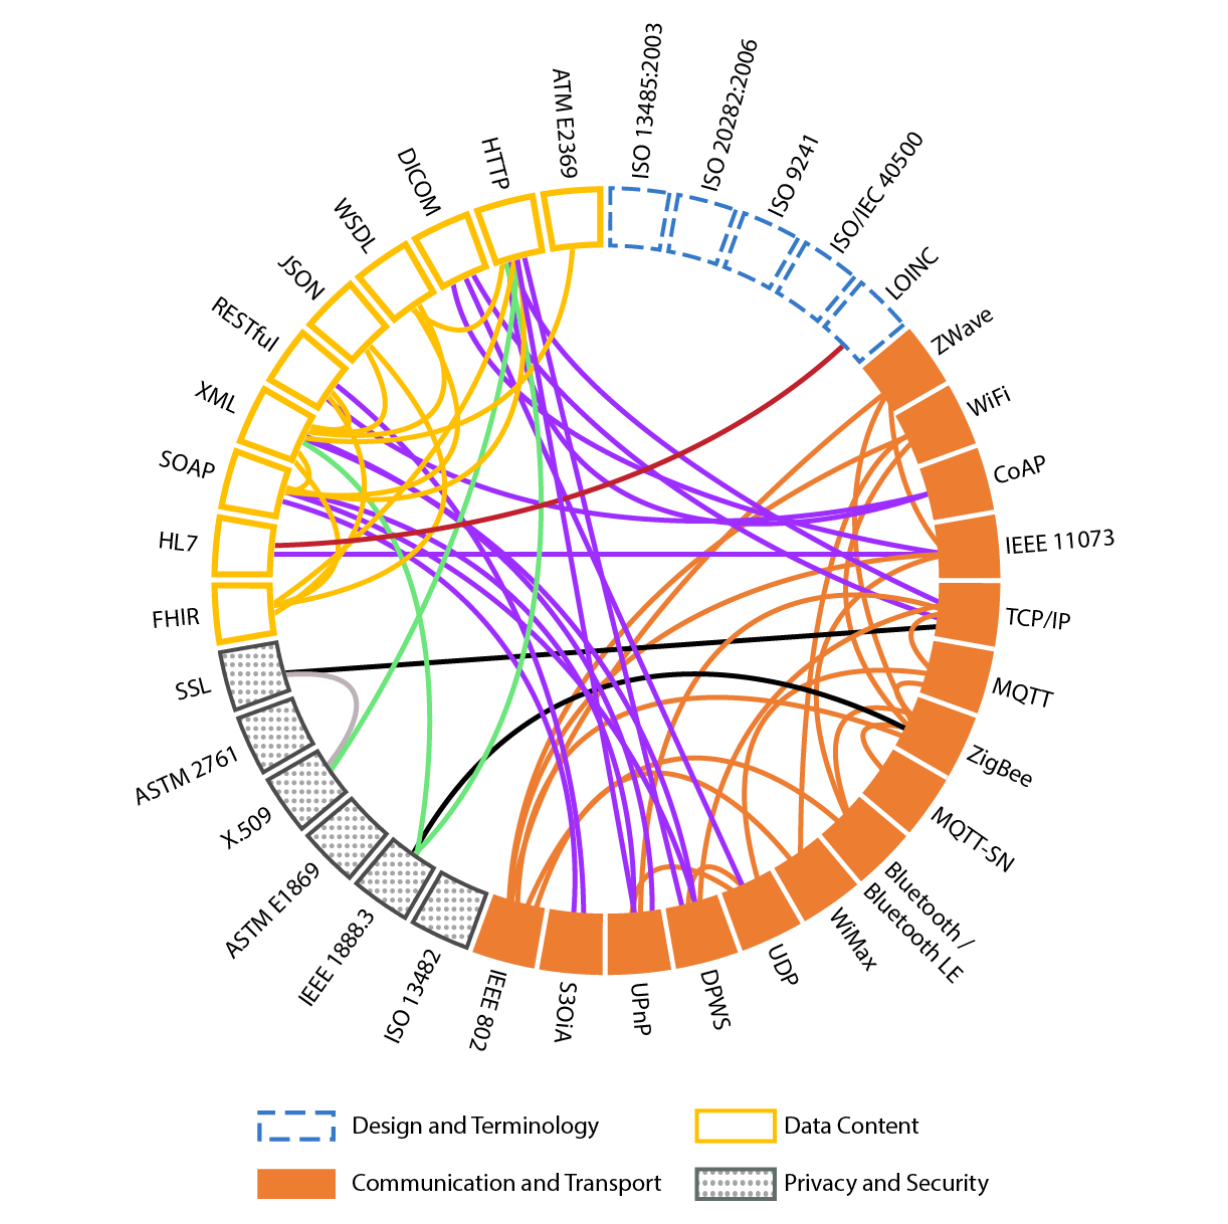
Figure 1. Relationship between standards and